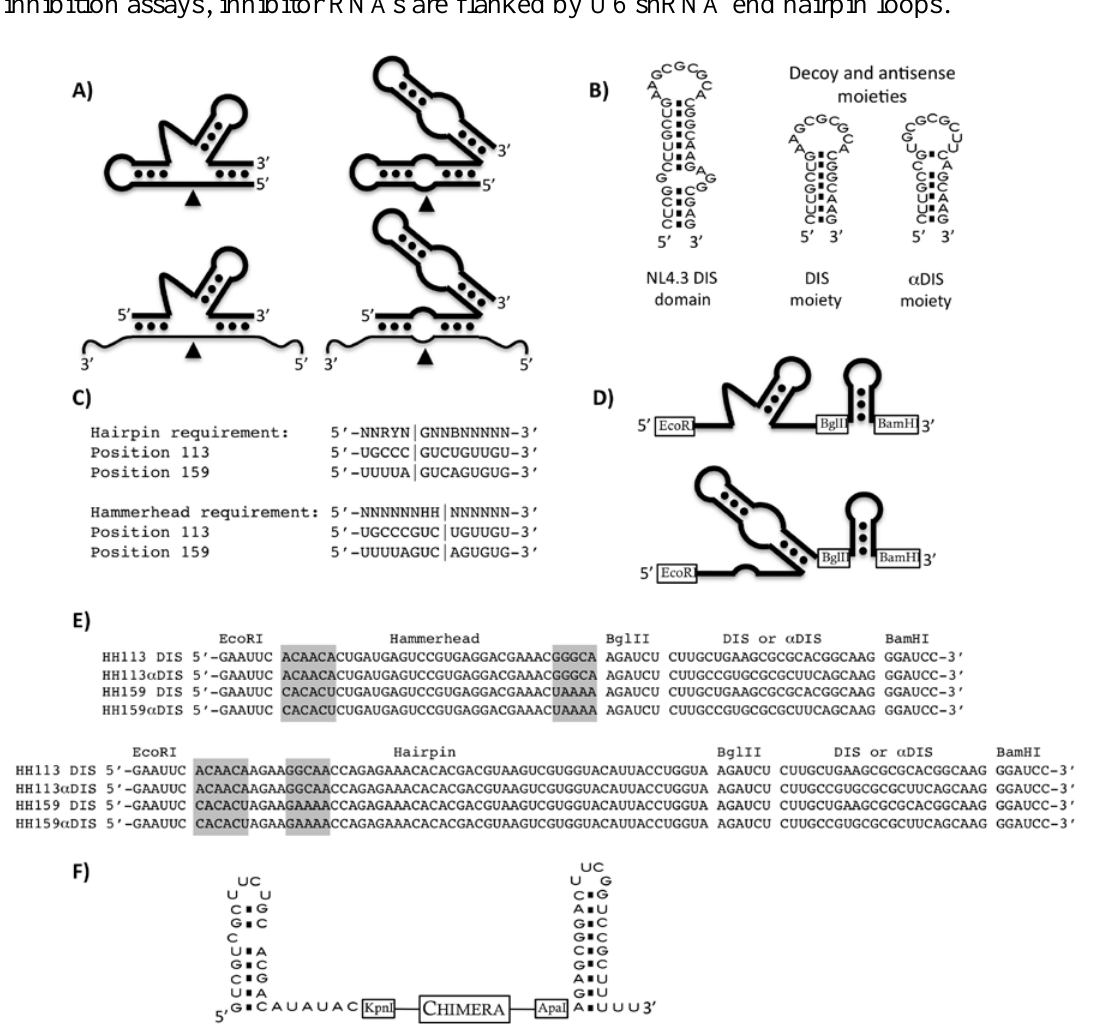
Figure 1. (a) Schematic representation of the catalytic RNAs. Self-cleaving hammerhead (top left) and hairpin (top right) ribozymes are represented. Engineered